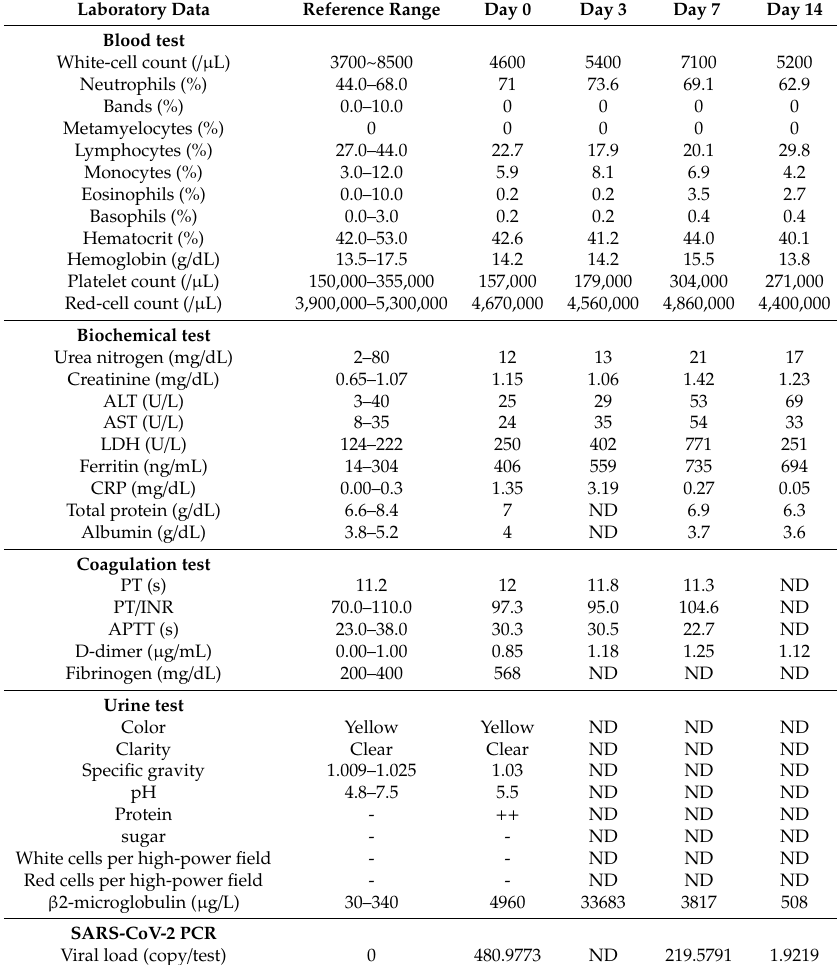
Table 1. Laboratory data from the patient during his hospitalization.